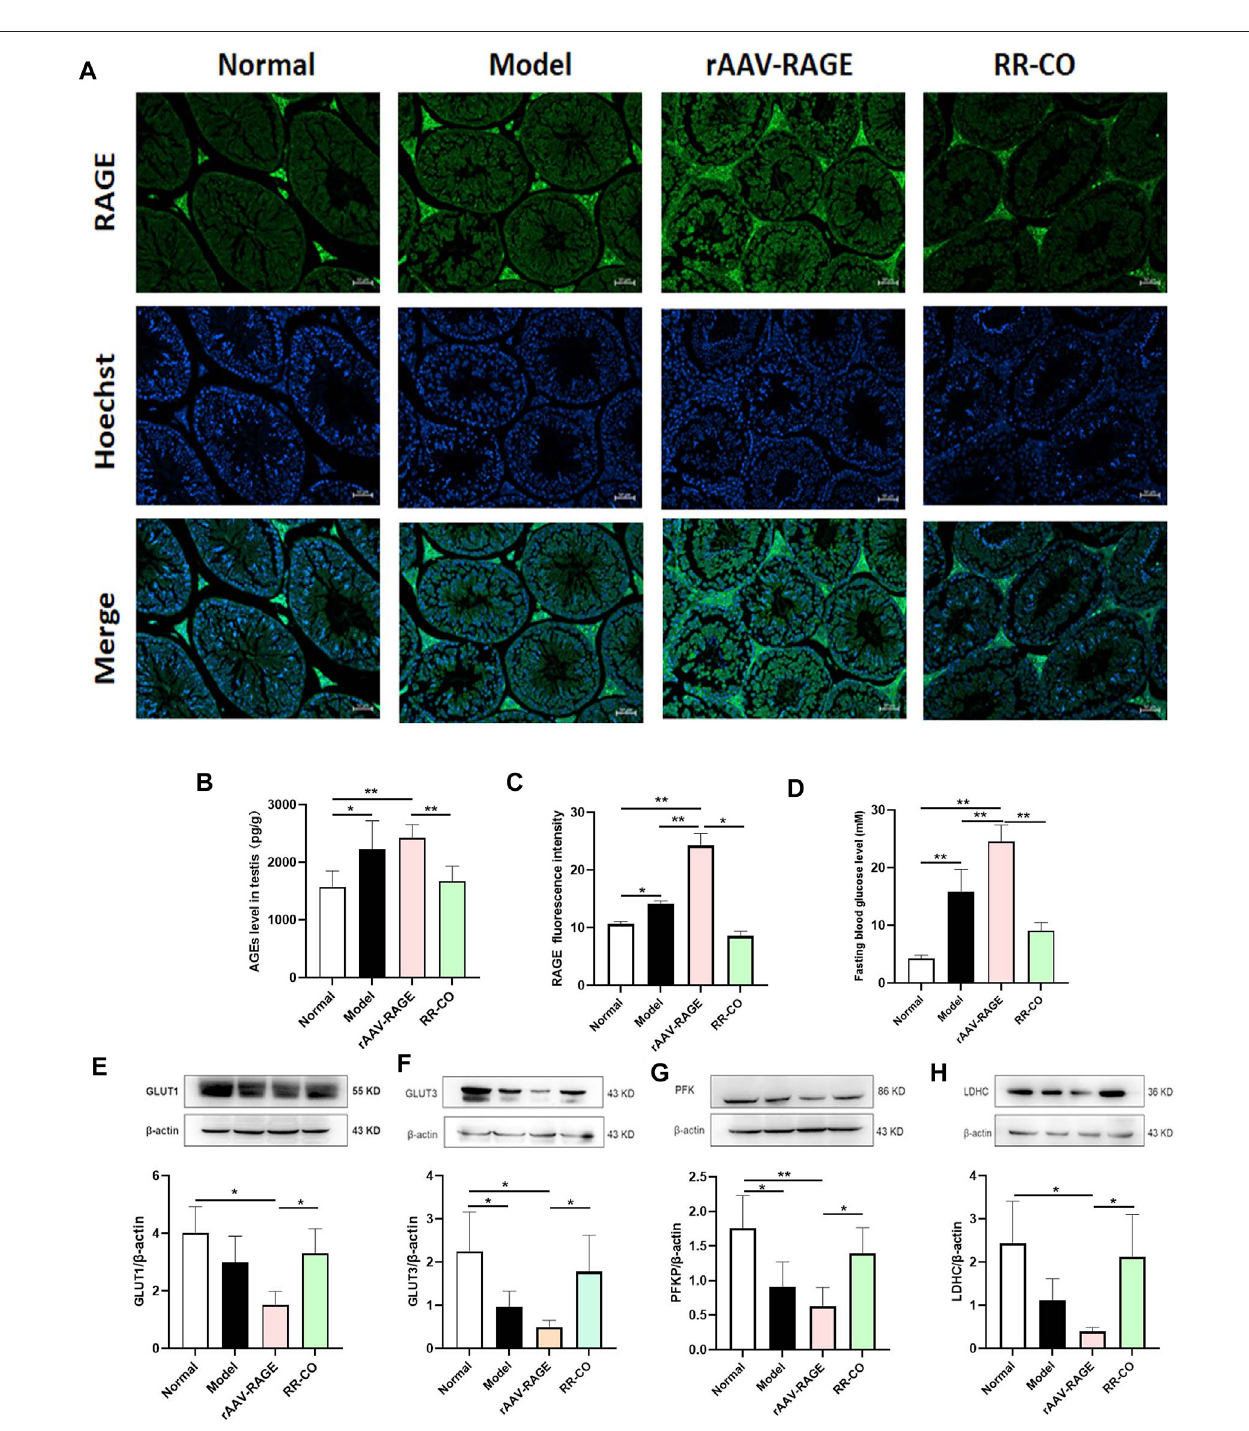
FIGURE 6 | RAGE overexpression aggravated the testicular injury and glycolysis inhibition (A) The expression of RAGE was detected by Immuno fl uorescence (B) AGEs level in testis detected by ELISA kit (C) Statistical graph of RAGE immuno fl uorescence intensity (D) FBG level (E) Western blot analysis of GLUT1 protein expression in the testis (F) Western blot analysis of GLUT3 protein expression in the testis (G) Western blot analysis of PFK protein expression in the testis (H) Western blot analysis of LDHC protein expression in the testis. Signi fi cance: * p < 0.05, ** p < 0.01.